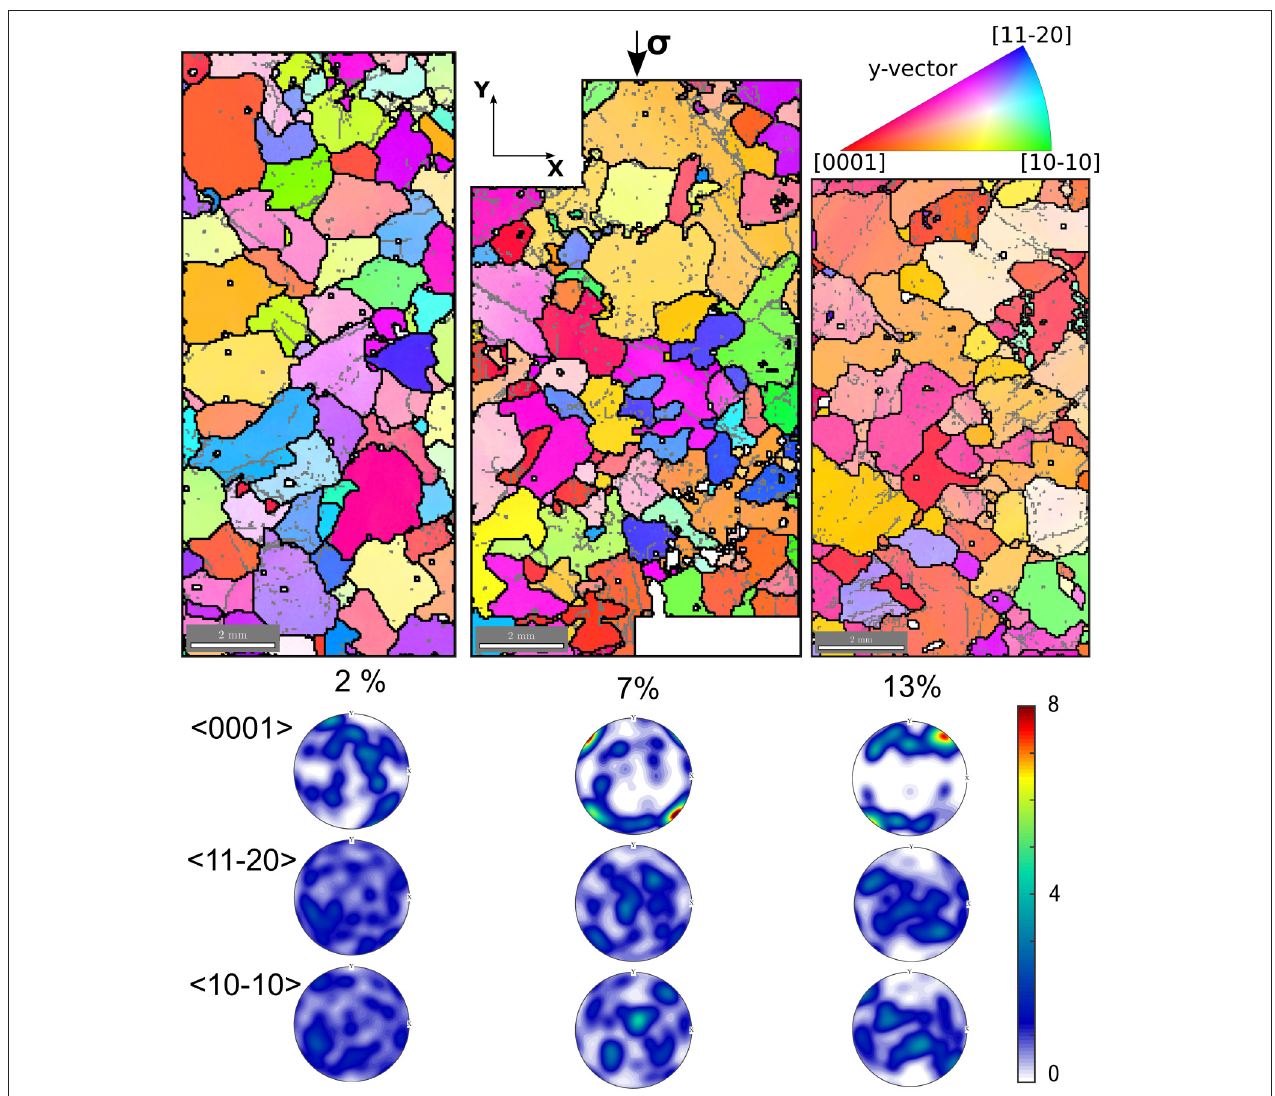
FIGURE 5 | Top: EBSD patterns and pole figures obtained after 2% strain (left), 7% strain (center), and 13% strain (right), at − 5 ◦ C. Coloring represents the orientation of the compression direction (y-vector) relative to the crystals’ axes accordingly to the inverse pole figure scheme displayed on the top right. Red crystals have < 0001 > parallel to the compression direction, blue ones have < 11 ¯ 20 > parallel to the compression axis, and green ones, < 10 ¯ 10 > . Boundaries with more than 5 ◦ misorientation are depicted as black lines, boundaries with misorientations between 1 and 5 ◦ as gray lines. Bottom: pole figures representing the orientation of the < 0001 > , < 10 ¯ 10 > , < 11 ¯ 20 > crystal axes relative to the compression direction, which is vertical in these lower hemisphere stereographic